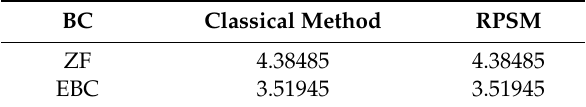
Table 15. The slab reactor critical radius for both boundary conditions.